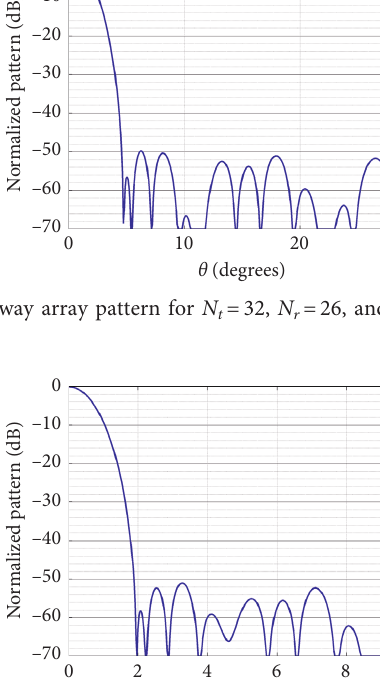
� 80, N � 64, and M � 40, W t r